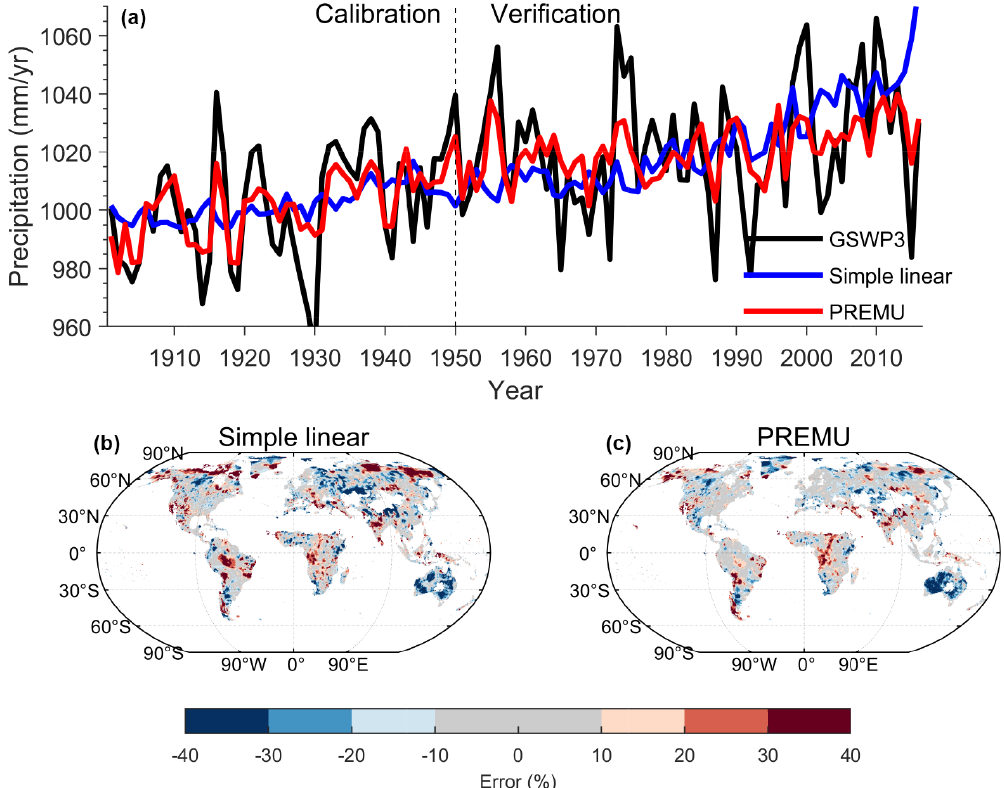
Figure 3. The emulation of historical precipitation. (a) GLAP of the historical observation precipitation (GSWP3) and the predicted precip- itation estimated by the simple linear method (simple linear) and by our emulator (PREMU) in 1901–2016. (b) The spatial pattern of error of MAP in 1987–2016 between simple linear and GSWP3. (c) The spatial pattern of error of the MAP in 1987–2016 for our emulator and for GSWP3. The global land average does not include Antarctica because of no emulation for Antarctica, and the arid areas where the MAP from GSWP3 is less than 200mmyr − 1 in 1980–2016 are